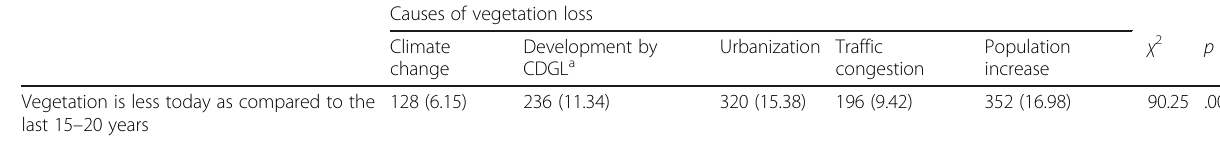
Table 4 Cross tabulation and chi-square test for responses on questions related to vegetation loss ( N = 2080)